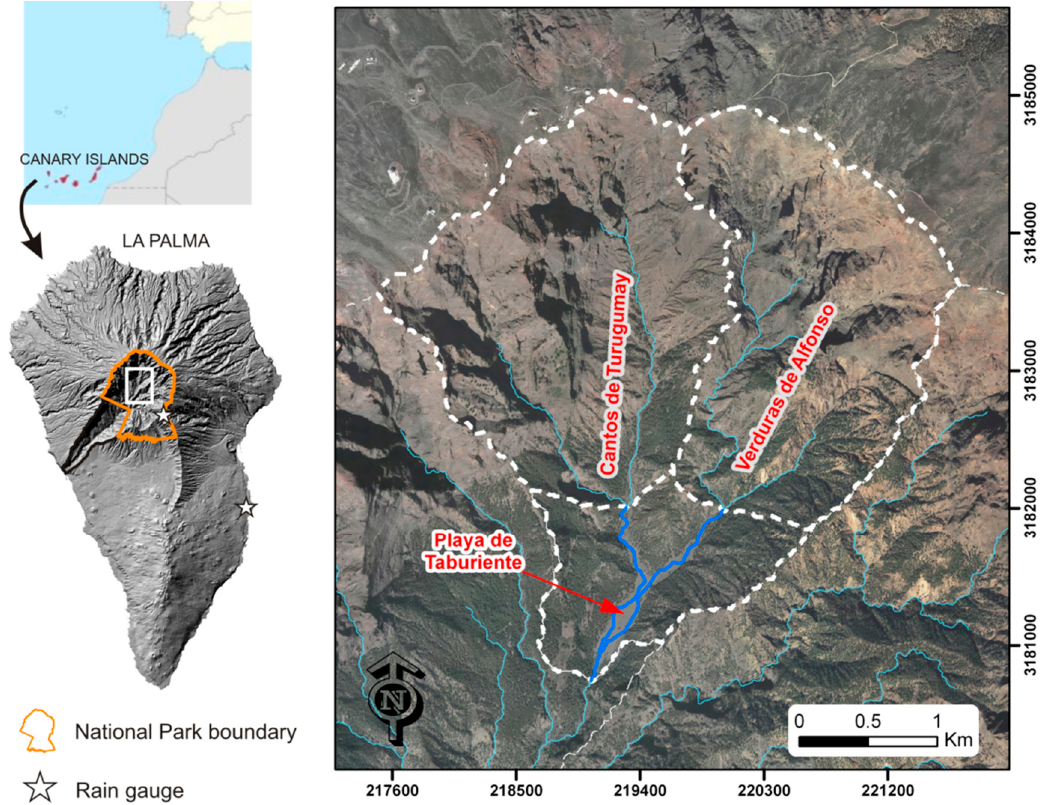
Figure 1. Location map of the “Playa de Taburiente” area and tributaries catchments, within the limits of the Caldera de Taburiente National Park, as well as its main elements (rain gauges, National Park boundary) of interest.